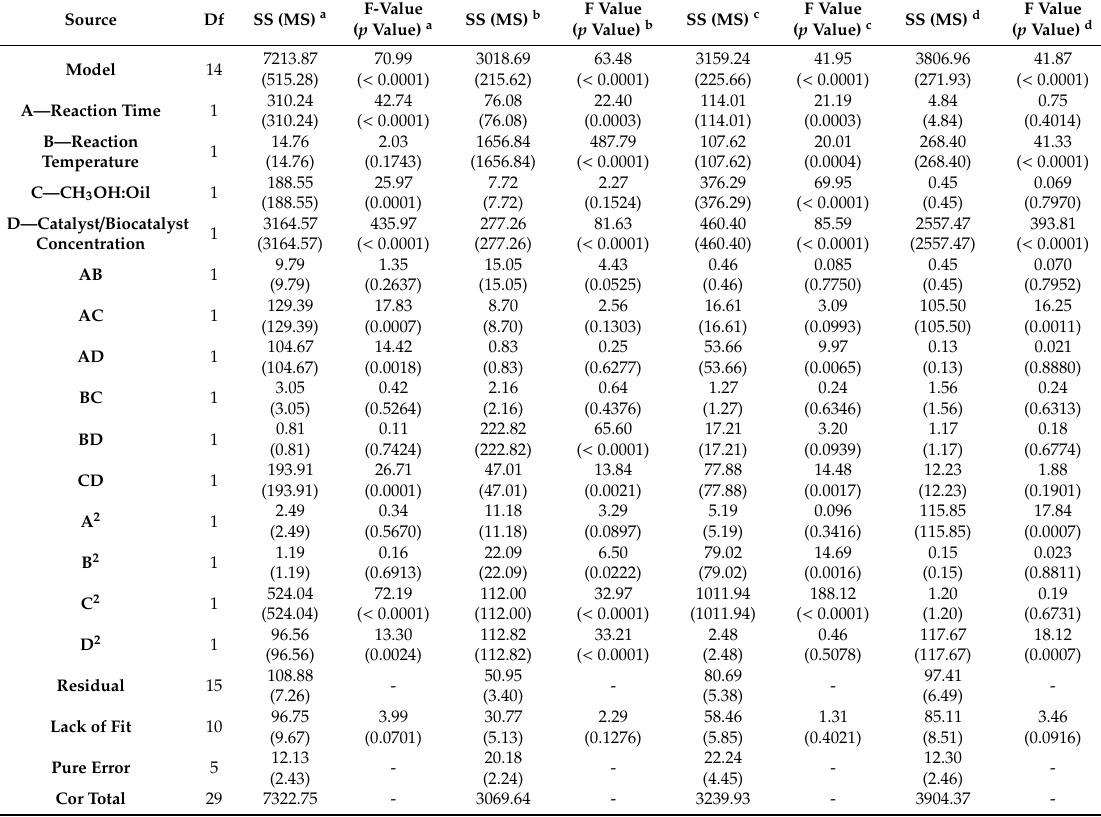
Table 3. RSM-based ANOVA for transesterification of waste chicken fat oil